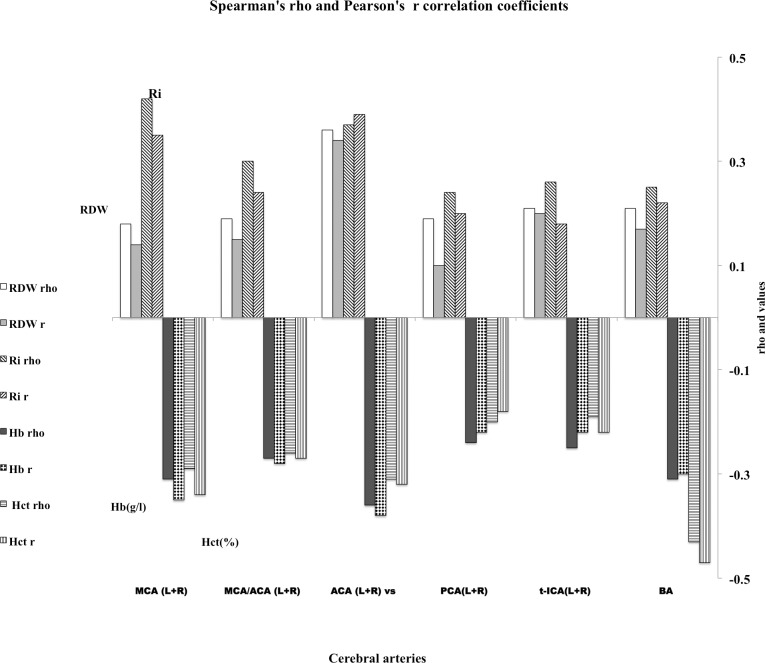
Spearman ρ and Pearson r correlation values between TCD velocities (TAMMV in cm/s) and rigidity index Ri, RDW, Hb, and Hct.Cerebral arteries MCA, MCA / ACA, ACA, PCA, t-ICA, BA, left and right. Data of patients SCA, SCC, SD, and Sβ0thal. Note that correlations are direct (positive values) between TCD velocities vs. (versus) Ri, and TCD vs. RDW, and inverse (negative values) between TCD velocities vs. Hb, and vs. Hct. Ri measured at Hct = 20 (0.2l/l); TAMMV-TCD, RDW, Hb, and Hct from Hemominas medical archives.